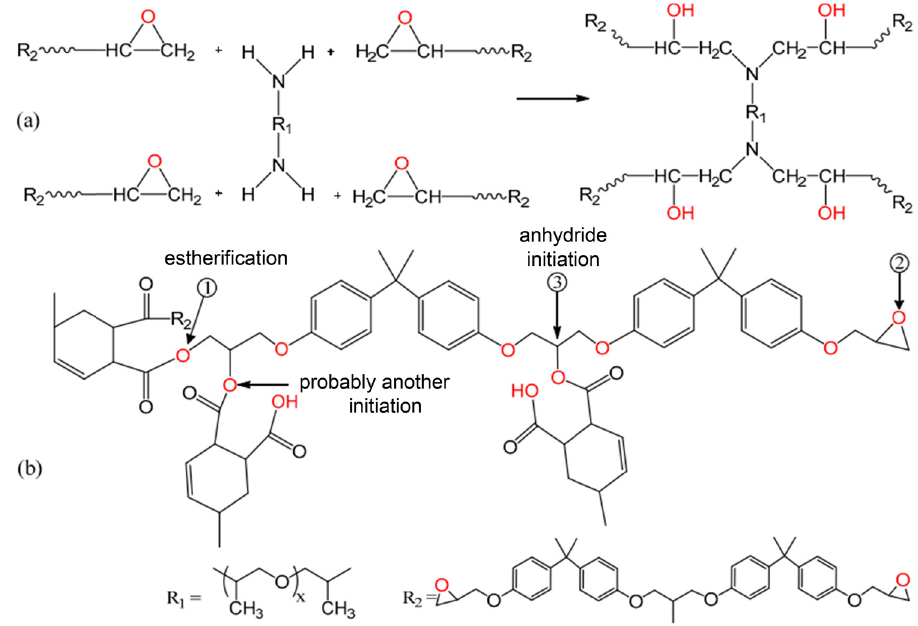
Figure 12: Networks scheme generated by reaction between epoxy DGEBA and ( a ) polyetheramine hardener and ( b ) anhydride hard - ener [ 60 ]